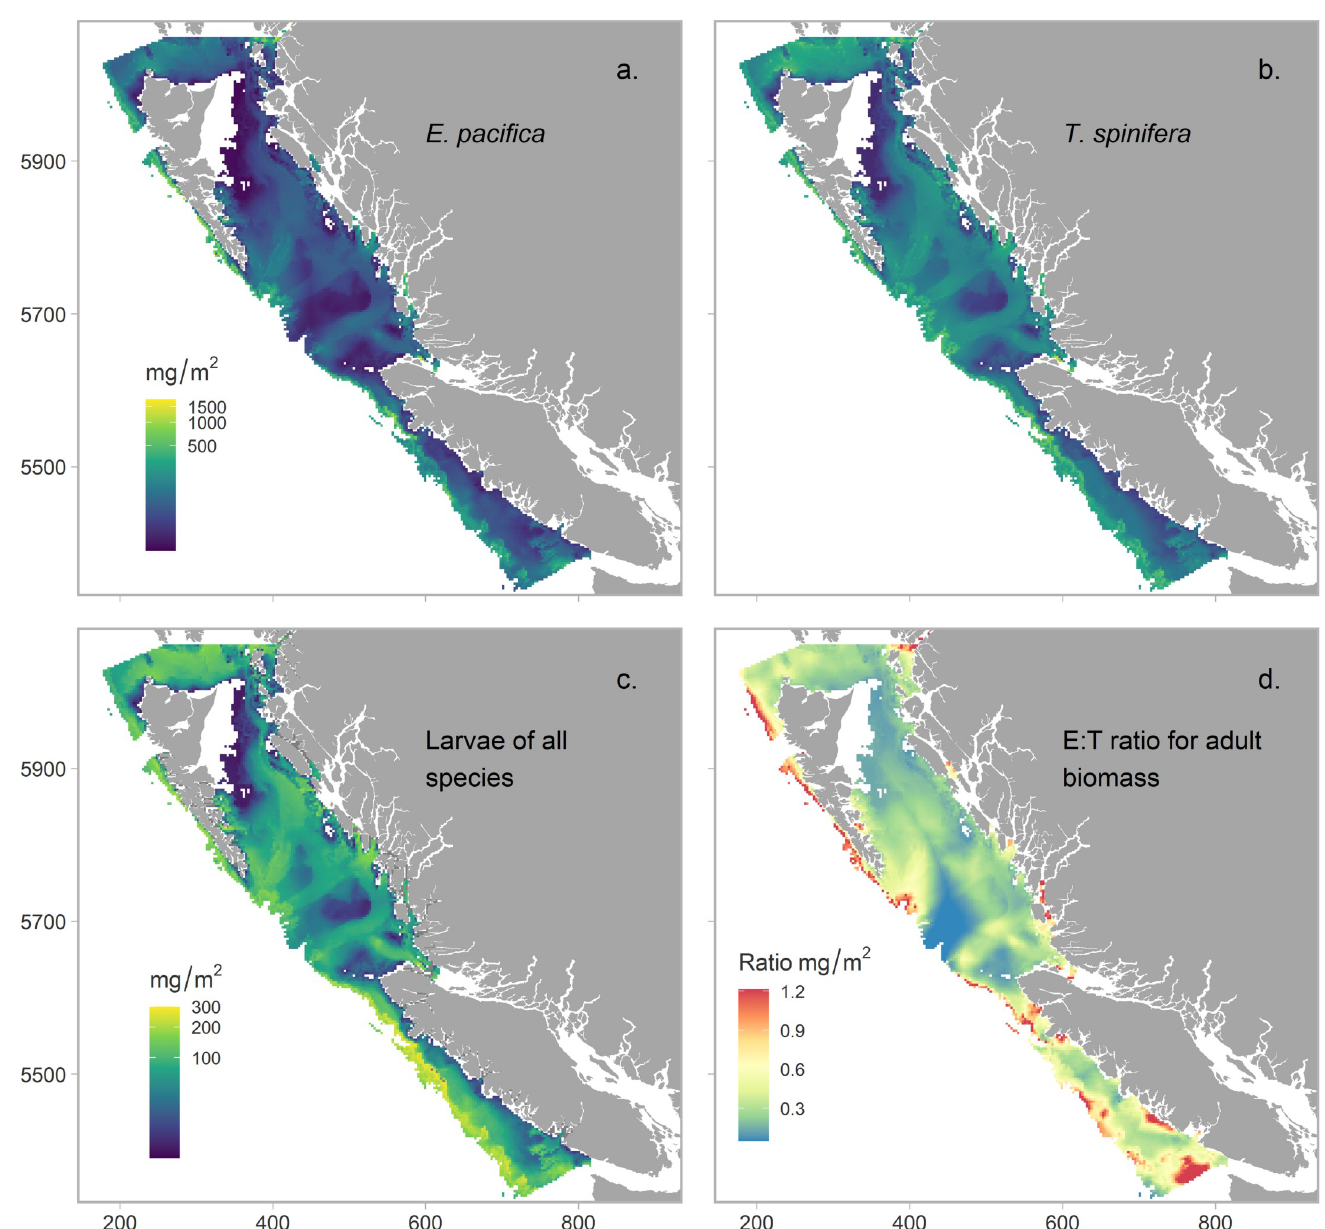
Fig 4. Mean predicted biomass from each model for a. E . pacifica , b. T spinifera , c. euphausiid larvae averaged across spring and summer (April-September). d. The spatial distribution of the predicted ratio of E . pacific a: T . spinifera biomass. All predictions were made across a 3km 2 prediction grid to 1000m depth. Mean calculations did not include predictions for April in the northern bioregion due to gaps in the observed